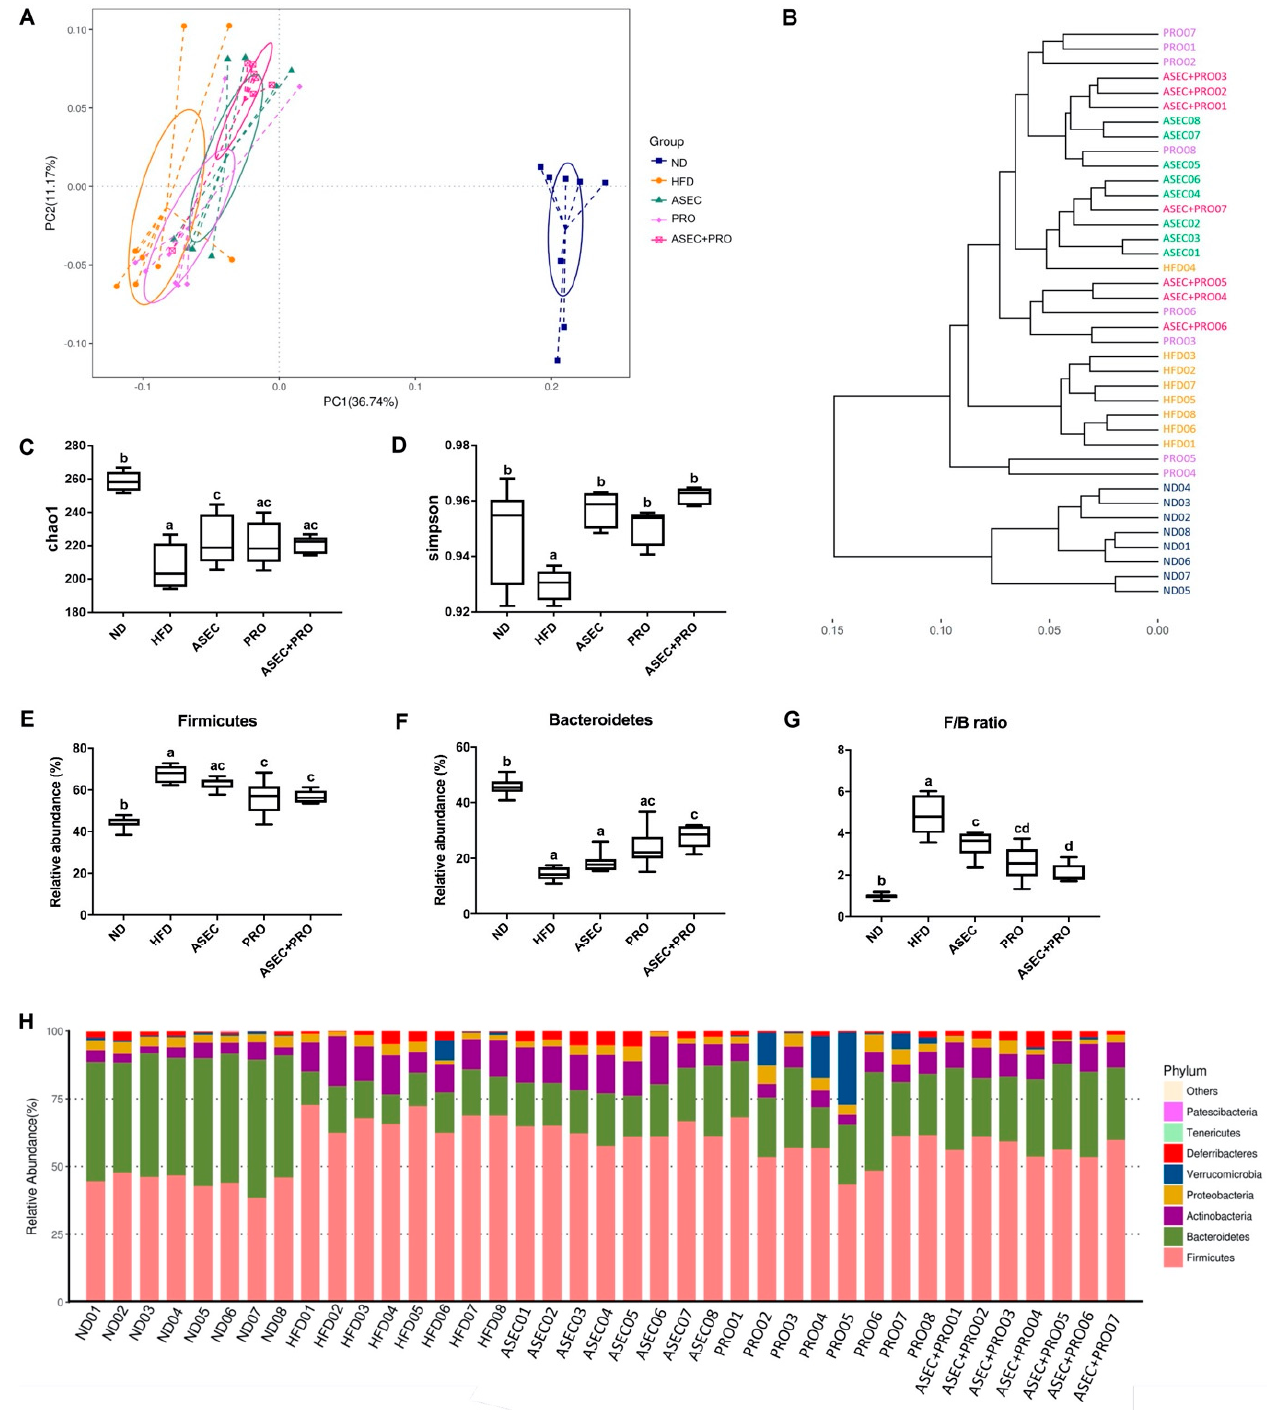
Figure 5. Intervention with ASEC, PRO, or ASEC + PRO improved the overall diversity and structure of gut bacteria in HFD-induced obese mice. Fecal metagenomics was performed using the V3–V4 of the 16S rRNA as the operational taxonomic unit (OTU). ( A ) Principal coordinates analysis (PCoA) of gut microbiota. ( B ) Unweighted pair group method with arithmetic mean (UPGMA) tree of gut bacteria. ( C ) Bacterial richness using the Chao1 index. ( D ) Bacterial diversity using the Simpsons diversity index. The relative abundance of phylum Firmicutes ( E ) and phylum Bacteroidetes ( F ) is shown. ( G ) The ratio of Firmicutes to Bacteroidetes (F/B ratio). ( H ) Taxonomic profiling of gut bacteria at the phylum level. Data ( n = 7–8) are expressed as the mean ± SEM. Statistical significance ( p < 0.05) is indicated by different letters (e.g., a, b).